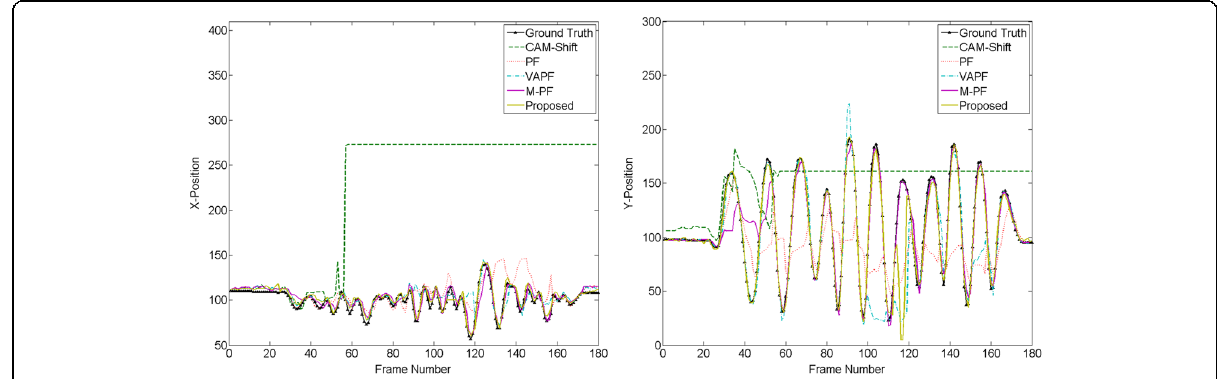
Fig. 23 Estimated object center position of “ book ” compared with ground truth with the particle number N = 150